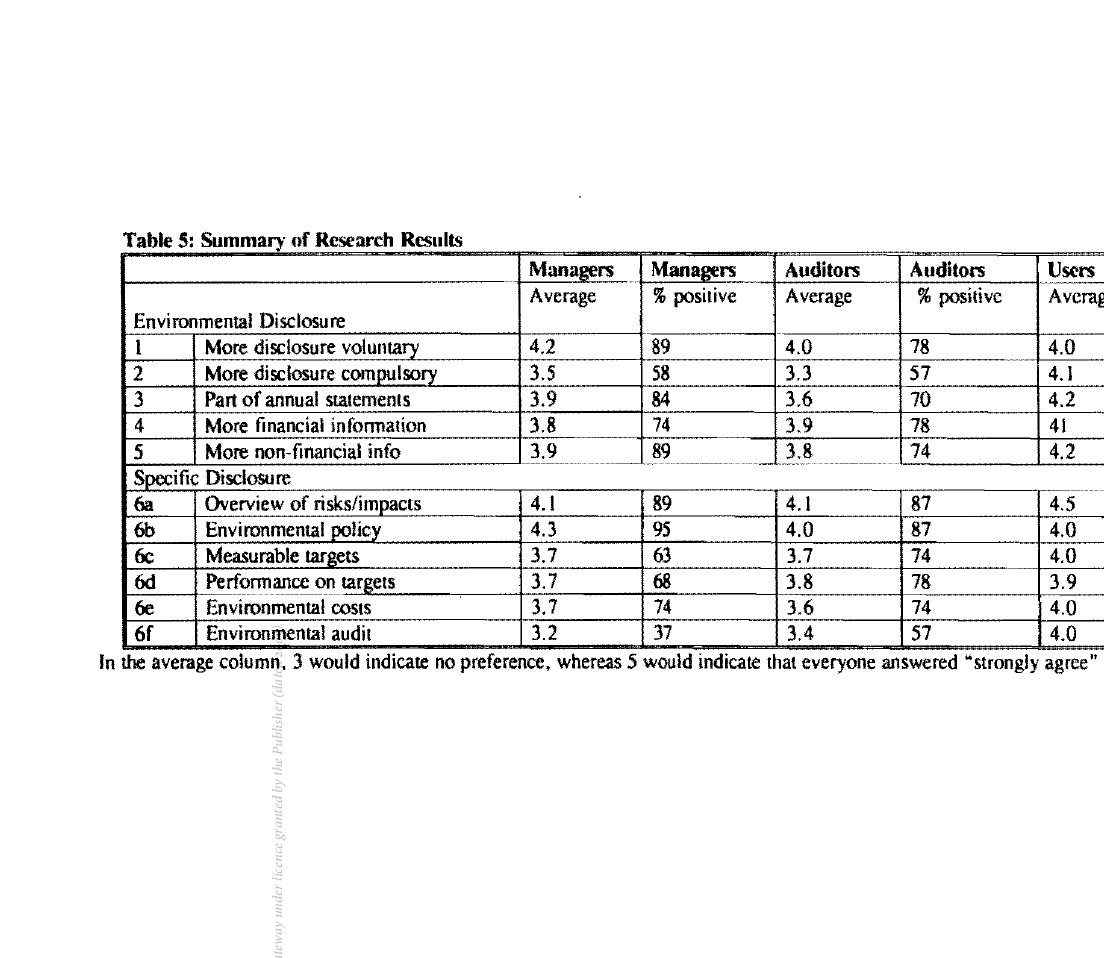
Table 5: Summary of Research